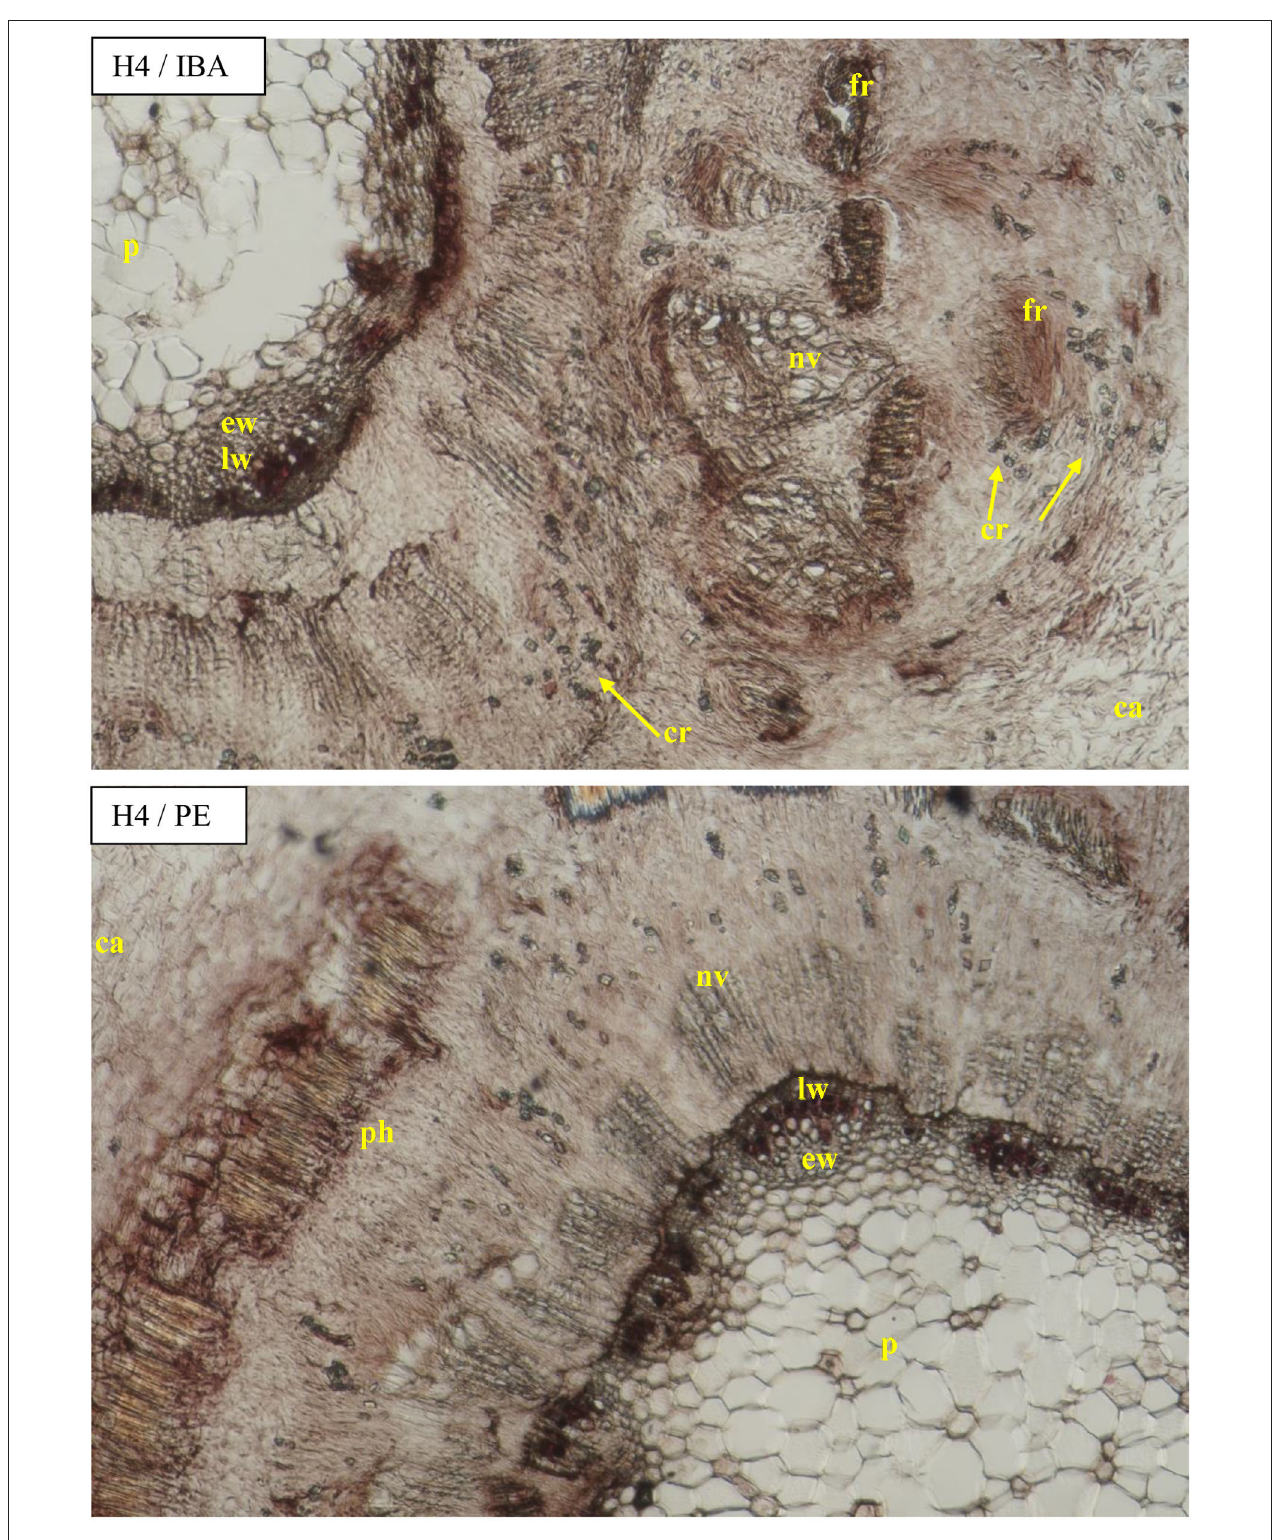
FIGURE 10 | Transverse sections of the shoots after 25 days of the process of rhizogenesis rooting in Rosa “Hurdal” in the phenological stage in BBCH scale (Meier et al., 2009) H4 − 70 701 [fruit set: beginning of hip (berry) growth on the main stem] cutting after treatment of IBA—Ukorzeniacz A aqua (0.4% IBA) and PE—Plant extract—watering with 0.02% Bio Roots (10ml) after planting. Designation of signs: ca, callus; co, cortex; cr, crystals; p, pith; pr, pith rays; ph, phloem; nv, new vessels/vascular bundles; ew, earlywood; lw, latewood; fr, forming root.